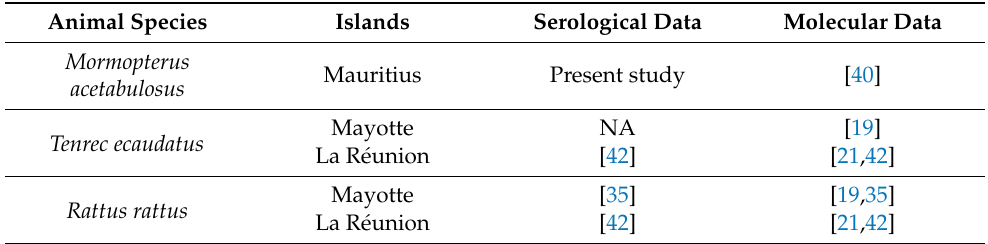
Table 1. Animal species used in the present study and the associated publications for Leptospira